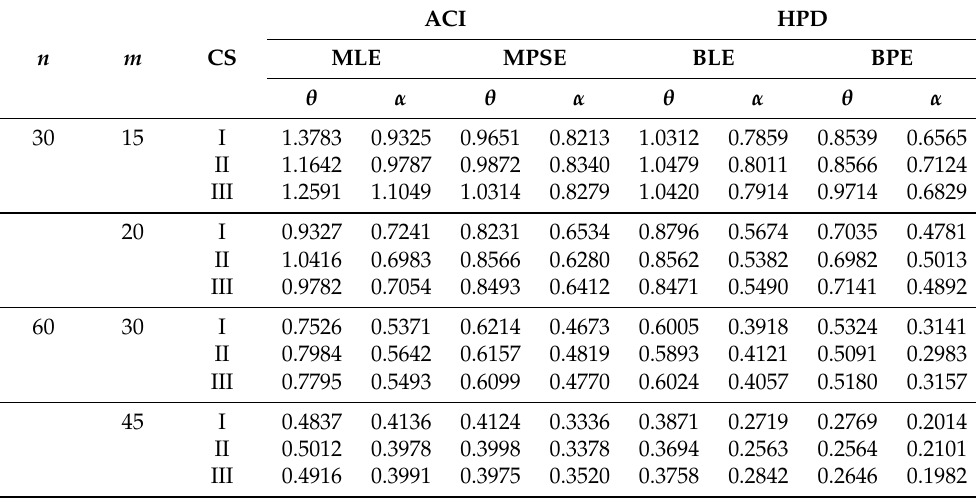
Table 4. The AWs for the model parameters at ( α , θ ) = ( 2.1,1.3 ) .